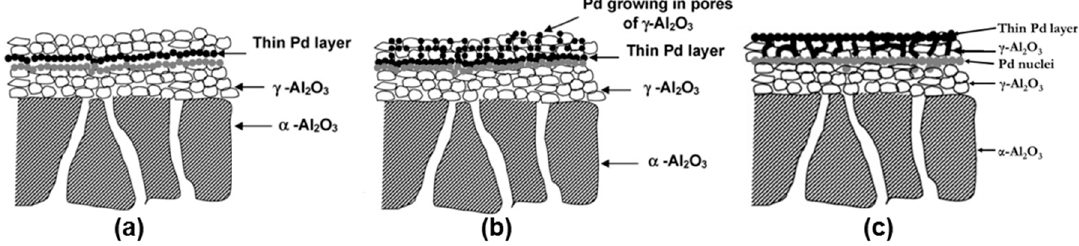
Figure 15. Schematic representation of encapsulated Pd ( a ), Pd encapsulated nanopore ( b ) and Pd nanopore ( c ). Reprinted from [199] with permission from Elsevier.